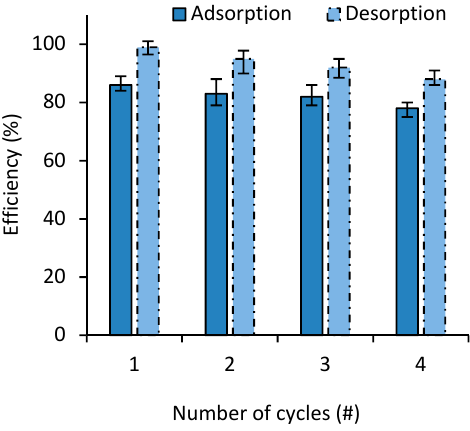
Figure 8. A suggested adsorption mechanism of PVA/CaCO 3 adsorbent for ( a ) MB, and ( b ) SF.